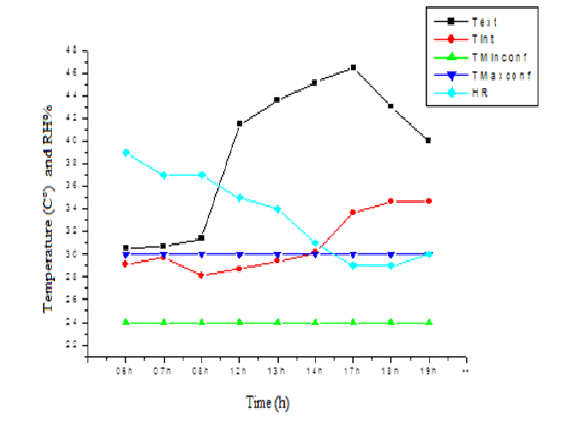
Figure 10. Changes of the internal and external temperatures and humidity during the day hours